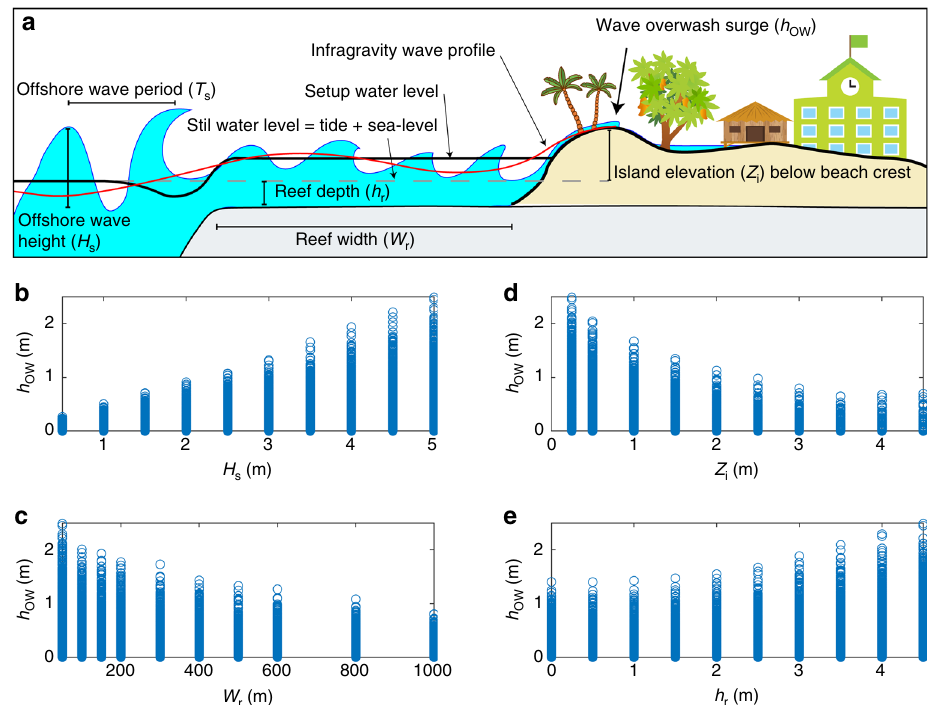
Fig. 1 Physical controls on wave-driven fl ooding on atoll islands. a Conceptual diagram of primary variables that in fl uence wave runup and overtopping on coral reef coastlines, highlighting the importance of wave setup and infragravity wave motions. b – e Model outputs showing the relationship between maximum wave overwash depth ( h ow ) at the beach crest for the 19,020 simulations where overtopping was identi fi ed and individual forcing variables: Offshore signi fi cant wave height ( H s ), island elevation above still water level ( Z i ), reef width ( W r ) and reef depth ( h r